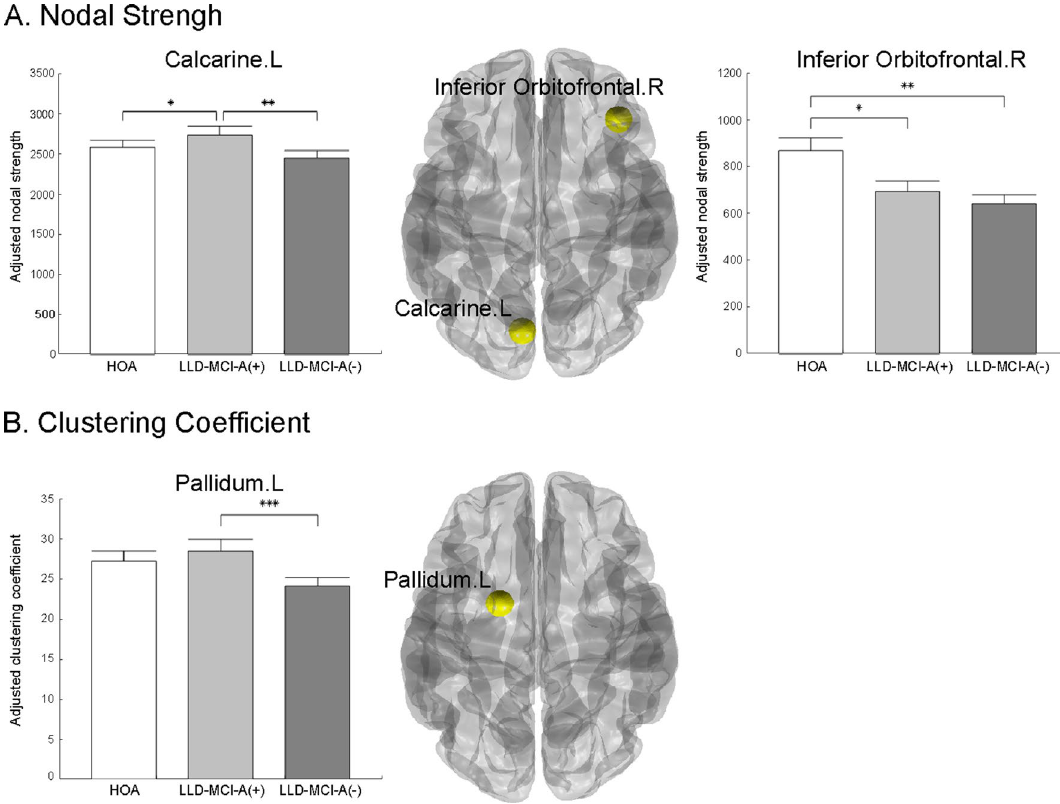
Figure 1. Between-group differences among the network measures. A between-group difference was found in the nodal strength ( A ) and clustering coefficient ( B ). Yellow circles in the middle brain images indicate the brain regions that show a group difference in the network measures. Bar graphs show the adjusted average values of the network measures in each group, controlling for age, gender, and education level. Whiskers of the bar graphs show the confidence intervals of the adjusted average values. All P-values were adjusted through the FDR procedure. *P < 0.05; **P < 0.01; ***P <